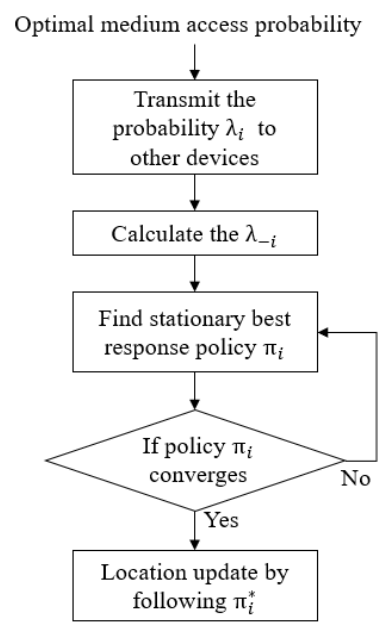
Figure 2. Diagram of IoT device i in DGLU.